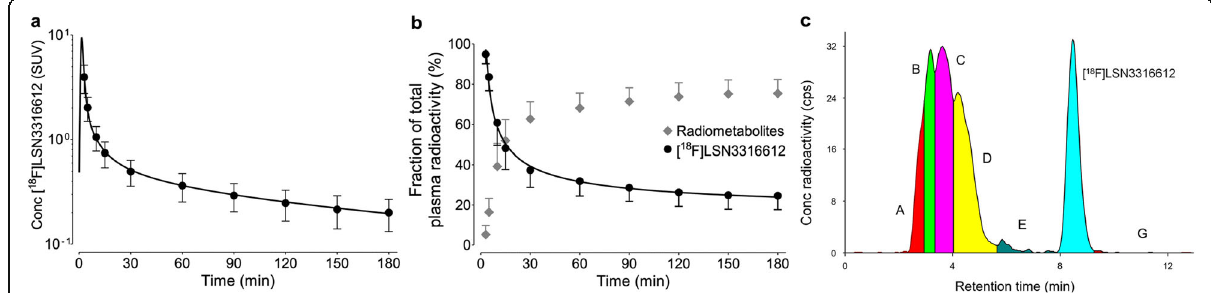
Fig. 3 Parent radioligand and radiometabolite profile in plasma after injection of [ 18 F]LSN3316612. a The mean concentration (±SD) of [ 18 F]LSN3316612 in plasma from 17 healthy volunteers. b The fractions (±SD) of parent radioligand and radiometabolites in plasma from 17 healthy volunteers. c High-performance liquid chromatography (HPLC) radiochromatogram of plasma content at 120 min after injection of [ 18 F]LSN3316612 in one healthy volunteer